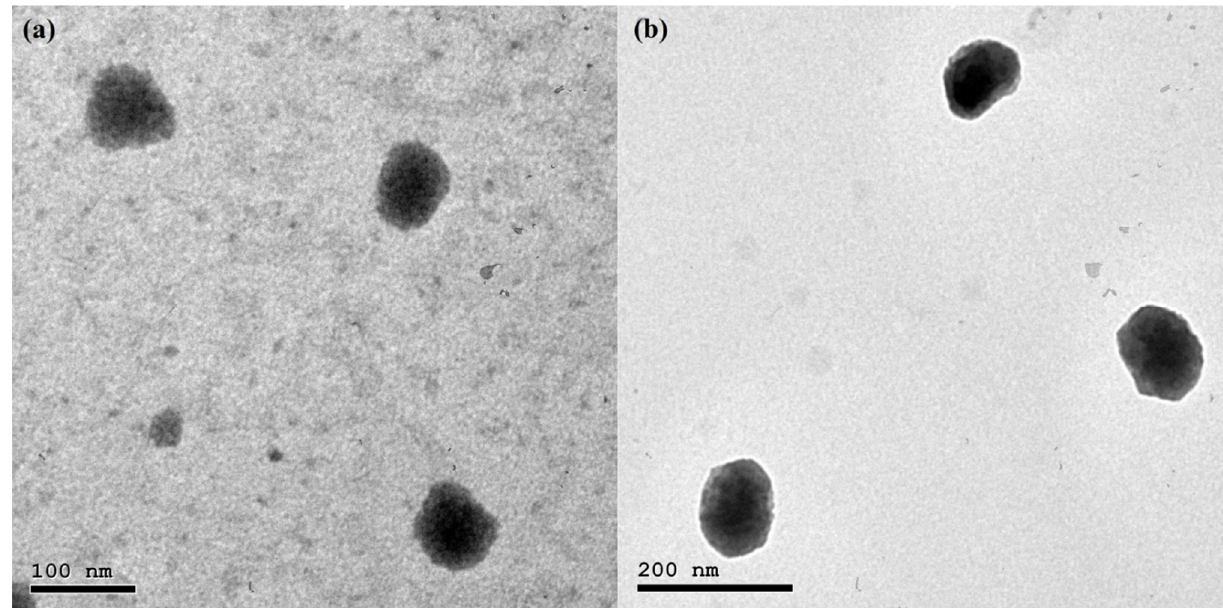
Figure 3. Transmission electron photomicrographs of ( a ) QRC ‐ NOVs, and ( b ) QRC ‐